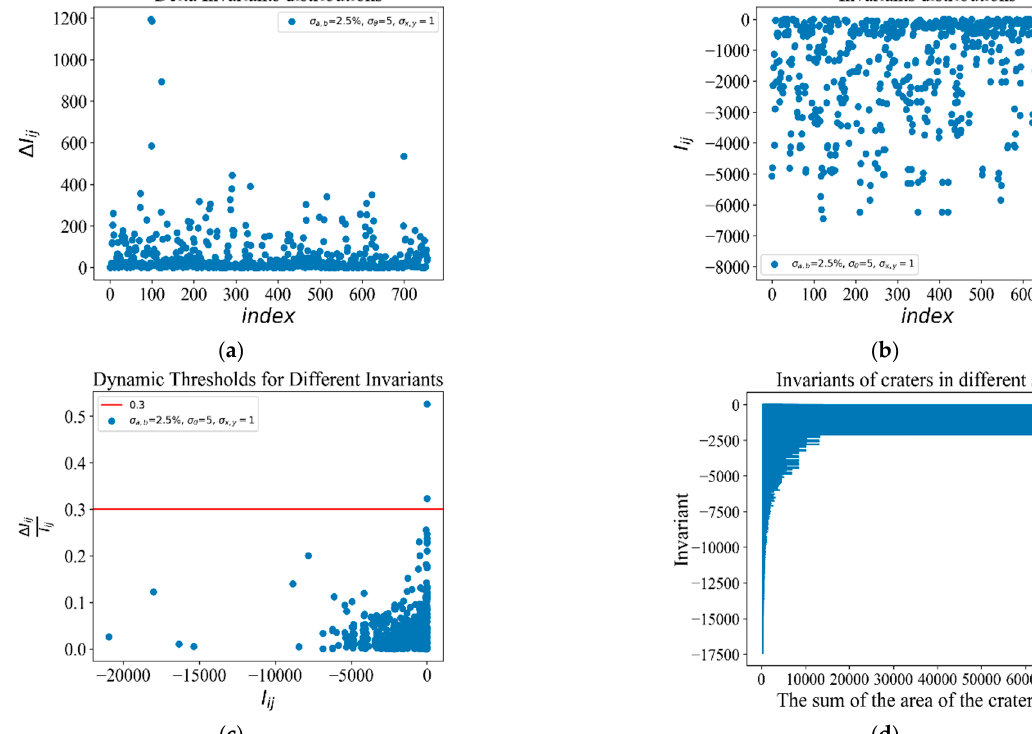
(cid:3057)(cid:3010) (cid:3284)(cid:3285) ∆ I for different crater pairs, ij for different crater pairs, where the red |(cid:3010) (cid:3284)(cid:3285) | | | I ij